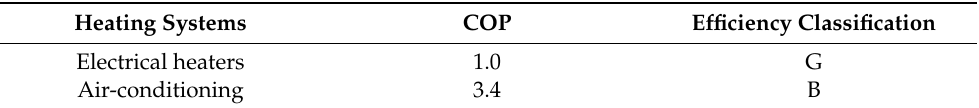
Table 2. COP index of heating systems